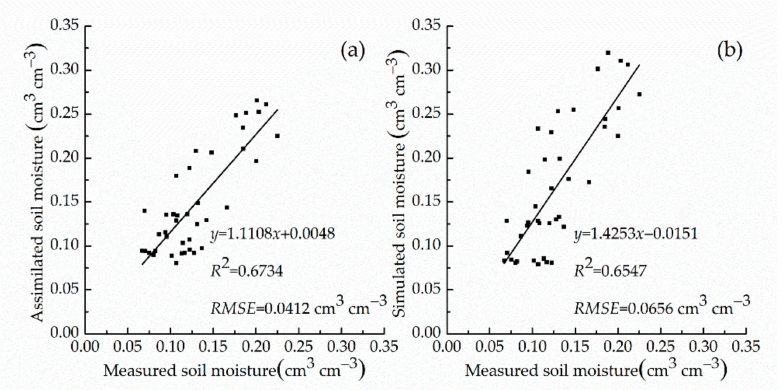
Figure 7. Linear regression analysis with measured soil moisture. ( a ) Assimilated soil moisture; ( b ) Simulated soil